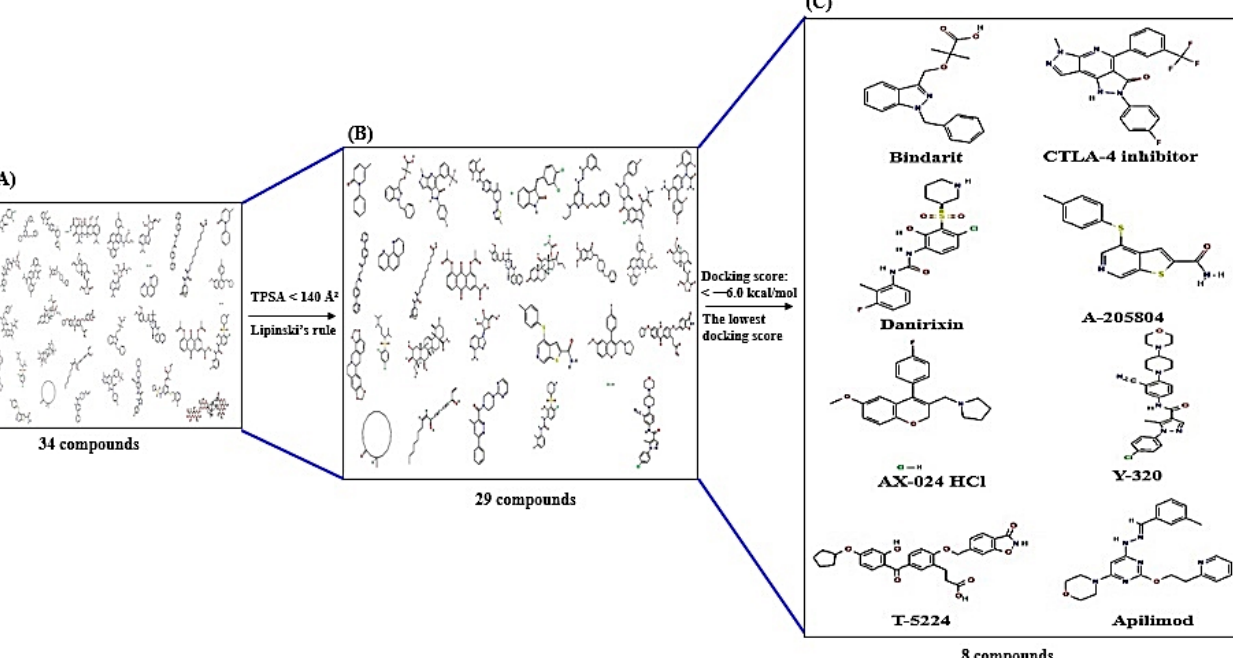
Figure 4. The filtering processing of significant compounds against AM. ( A ) A total of 34 compounds were related to the uppermost 8 targets. ( B ) A total of 29 compounds were filtered from A (TPSA <140 Å 2 or Lipinski’s rule). ( C ) A total of the uppermost 8 compounds were filtered from B (docking score < − 6.0 kcal/mol or the lowest docking score). The MDT of eight ligands demonstrated that (1) Bindarit (PubChem ID: 71354) had the greatest affinity of -7.2 kcal/mol on CCL2 (PDB ID: 1DON) (Figure 5A), (2) CTLA4